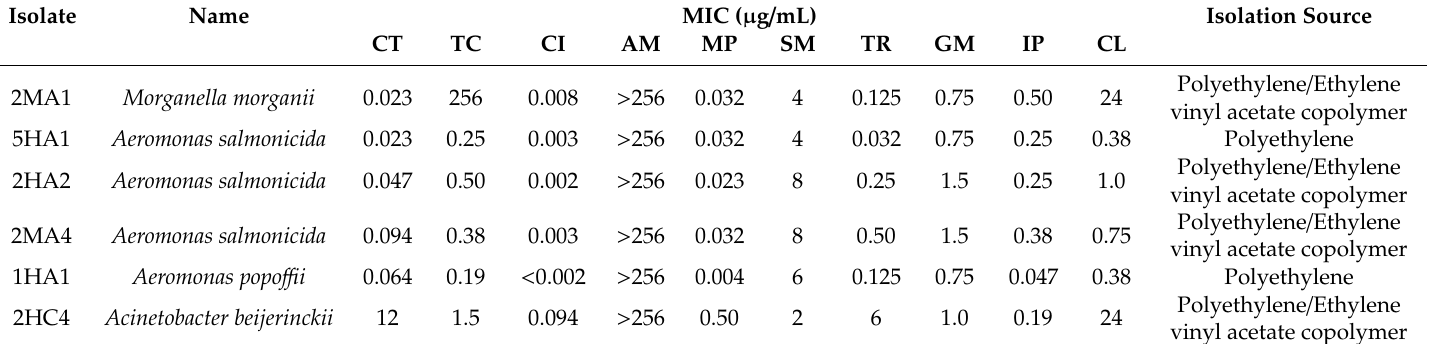
Table 1. Minimum inhibitory concentration (MIC) of di ff erent antibiotics.